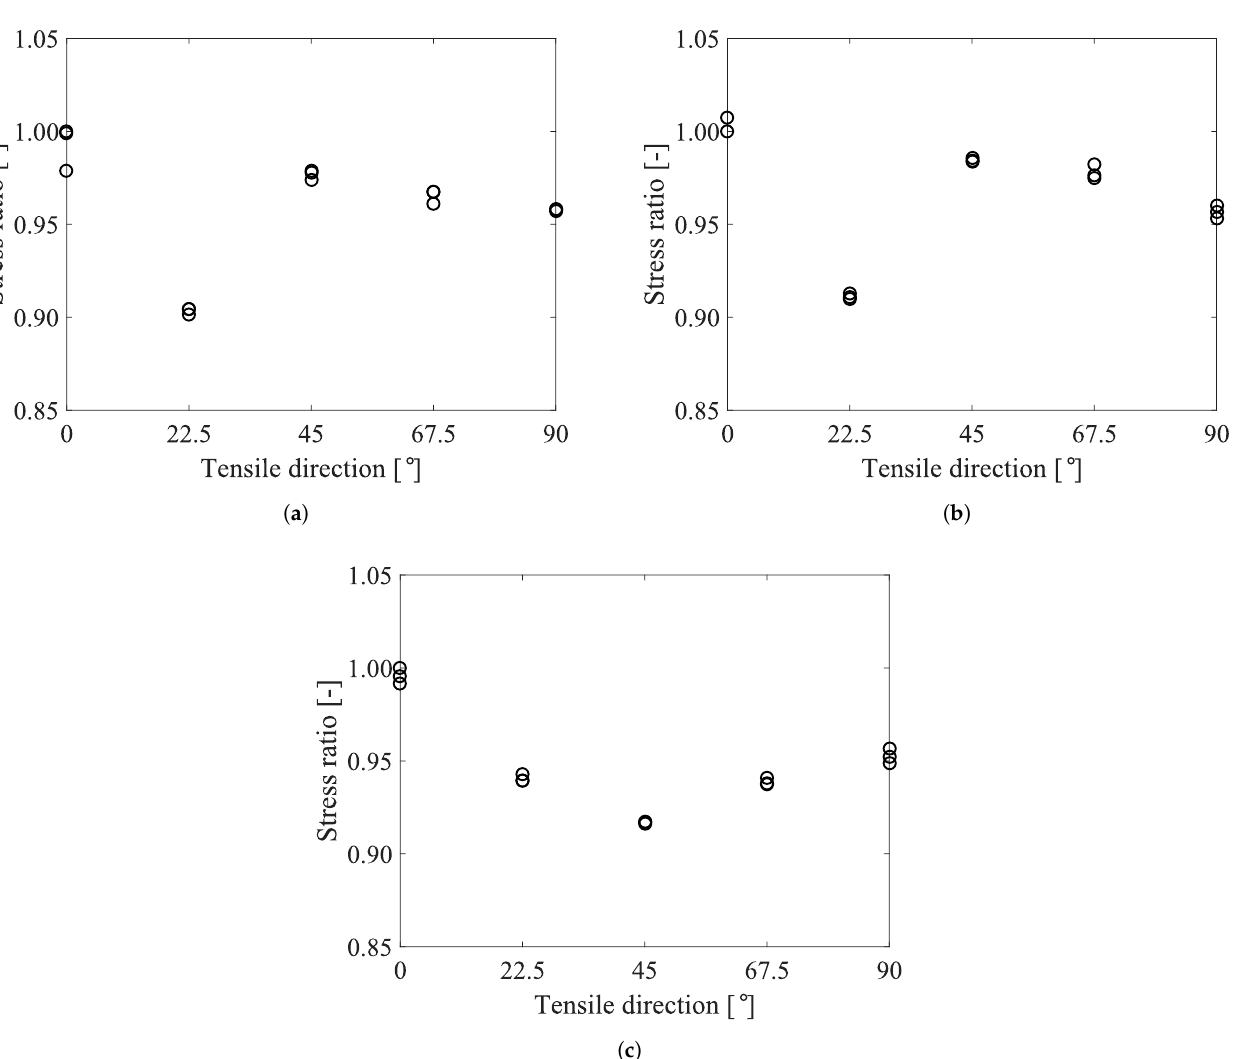
Figure 9. Stress ratio versus tensile direction from the tensile tests on the smooth specimen in the various tensile directions of alloy ( a ) AA6061, ( b ) AA6063 and ( c )